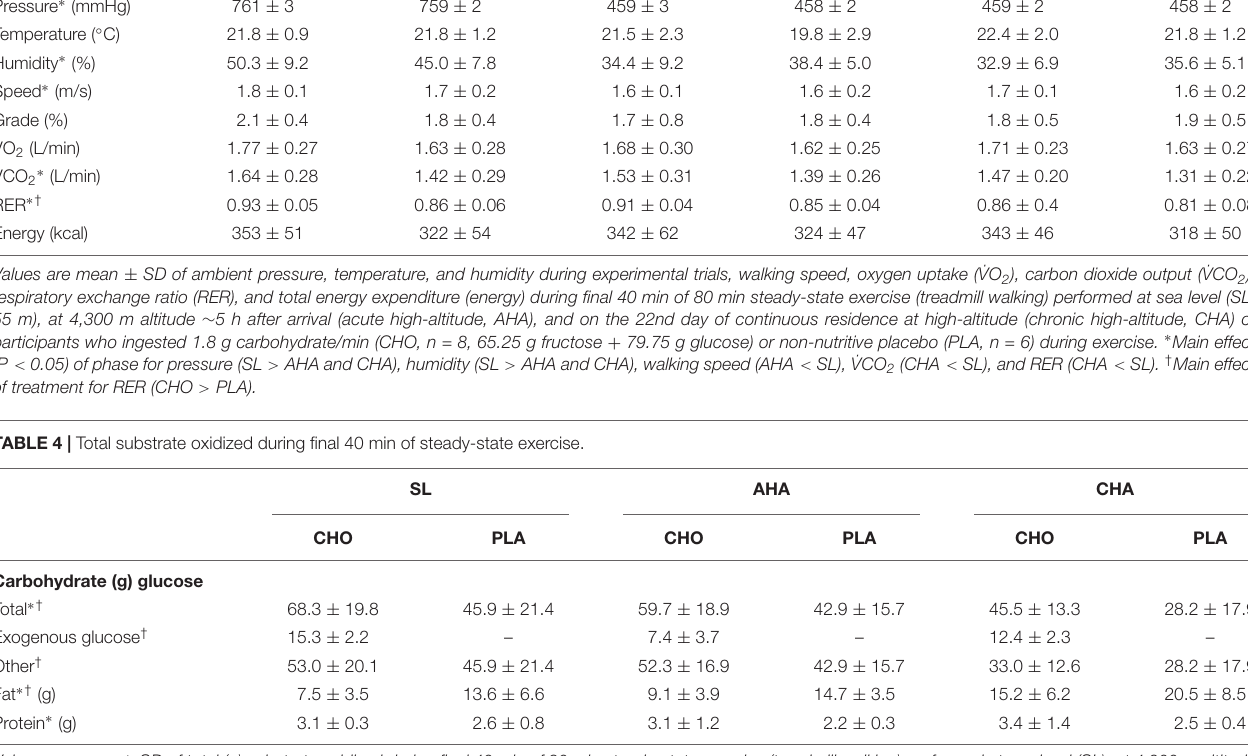
TABLE 3 | Ambient testing conditions during steady-state experiments, exercise intensity, respiratory gas exchange and energy expended during final 40 min of steady-state exercise. SL AHA CHA CHO PLA CHO PLA CHO PLA